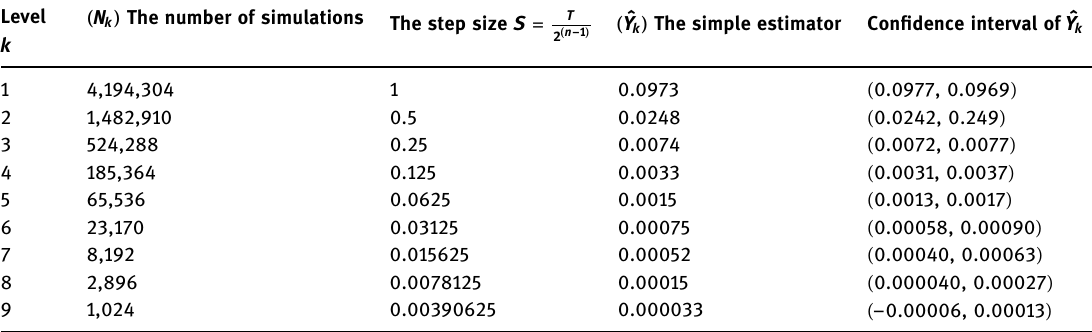
Table 1: The multilevel MC with the exact coupling two - dimensional SDE